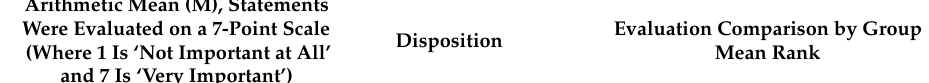
Table 8. Evaluation of the need to improve critical thinking dispositions/evaluation comparison by